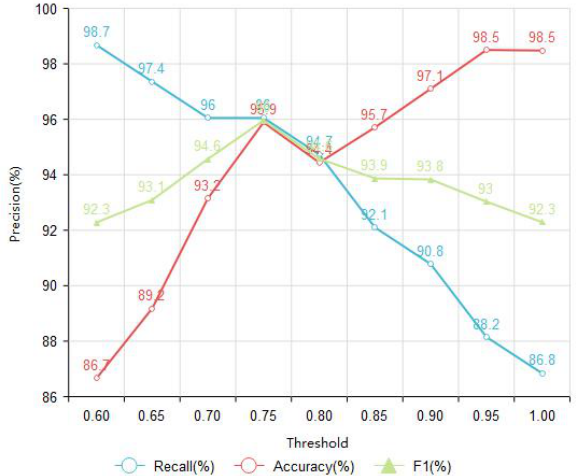
Figure 3 . Recall rate, accuracy rate and F1 value of POI points with the same name under different thresholds.